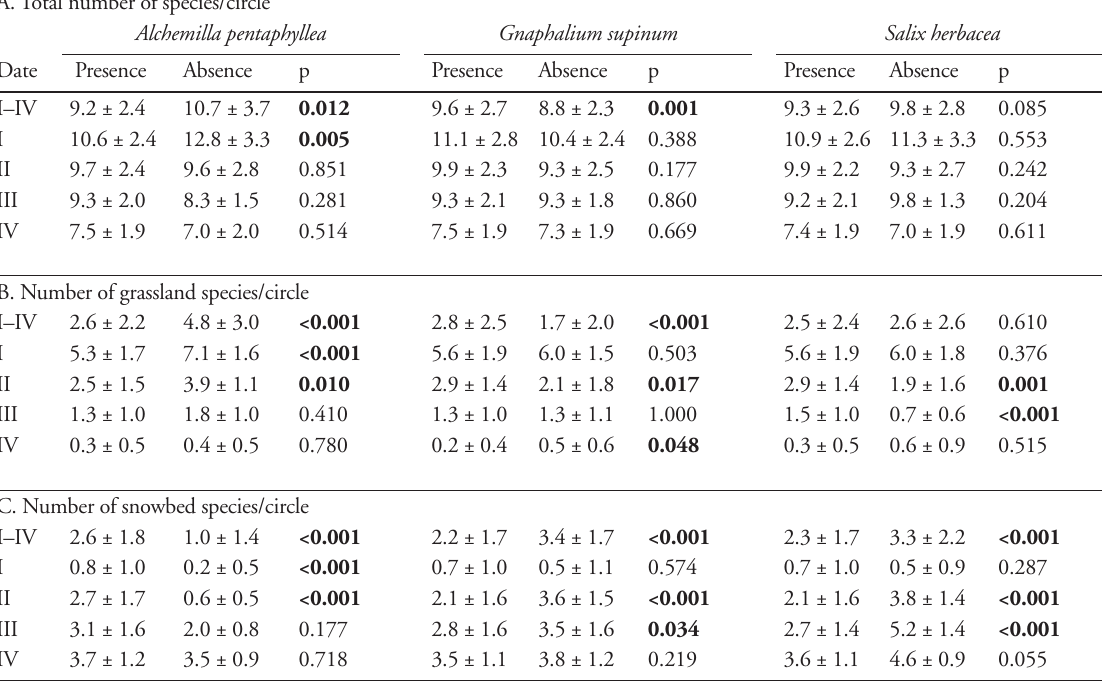
Table 4. Mean total number of species (A), number of alpine grassland species (B), and number of subordinate snowbed species (C) in circles ± 1 SD in the presence versus absence of the dominant species over the whole snowmelt gradient and for each snowmelt date separately. Significant differences in species richness in presence versus absence of a dominant species were tested by independent- samples t-test. Significant p-values at < 0.05 in bold. Snowmelt dates: I = 2 Jun 2003, II = 9 Jun 2003, III = 16 Jun 2003, IV = 23